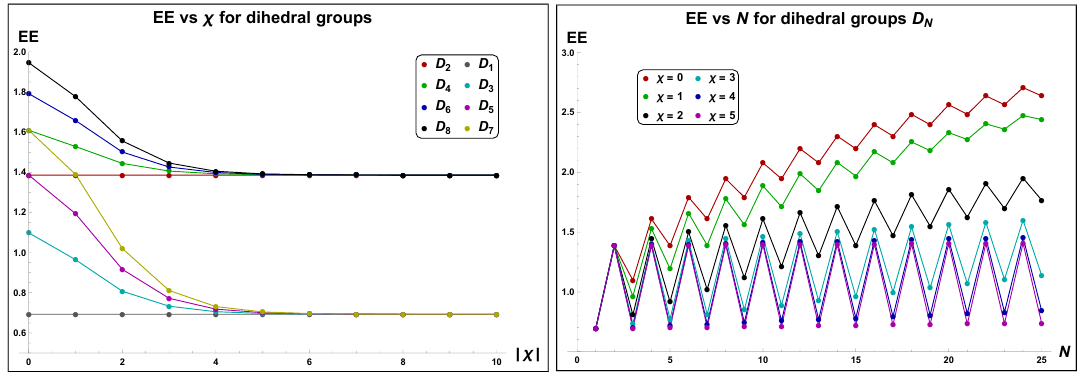
Figure 4 . The variation of entropy with Euler characteristic (cid:31) and with N for the dihedral group D N . The asymptotic values follow the limits given in eq.